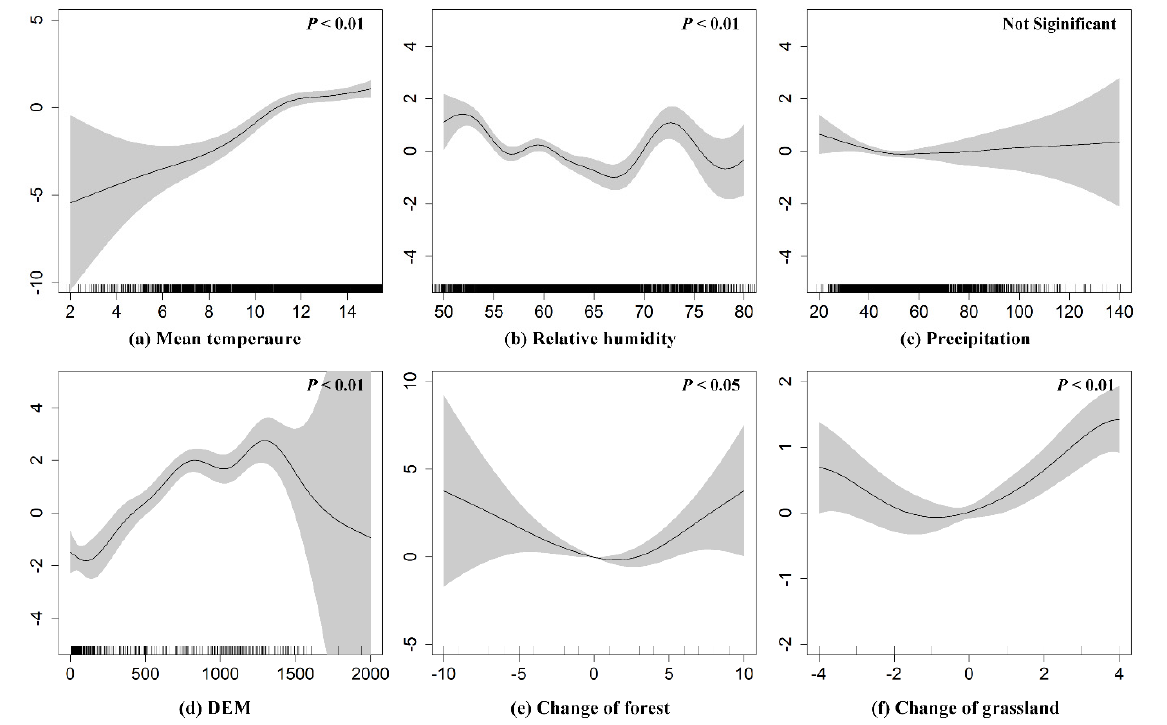
Figure 4. The relationships of spatial predictors on VL cases in central China: ( a ) mean temperature; ( b ) relative humidity; ( c ) precipitation; ( d ) DEM; ( e ) change in forest; ( f ) change in grassland.